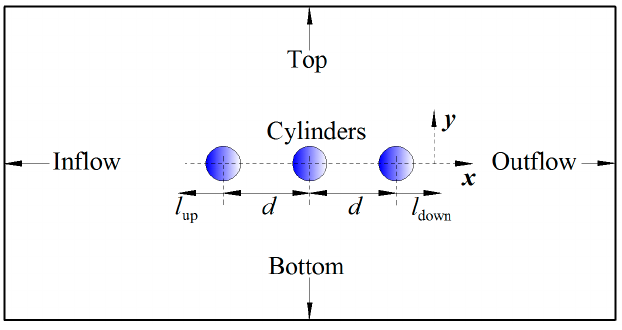
Figure 2. Computational domain.